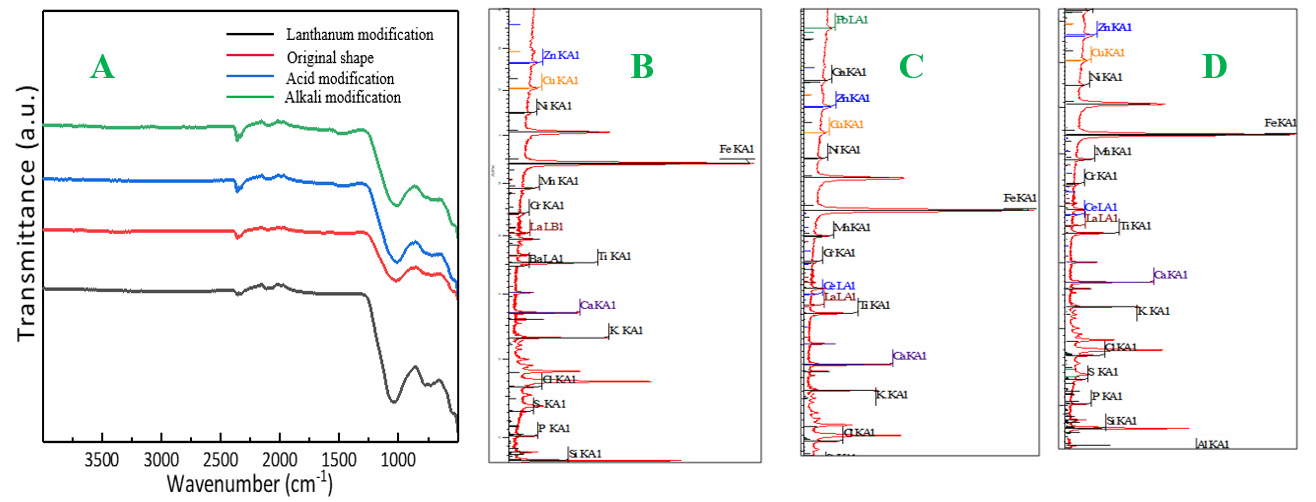
Figure 4. ( A ) Infrared spectra of four modified fly ashes; ( B ) XRF curves of acid modification; ( C ) XRF curves of alkali modification; ( D ) XRF curves of lanthanum modification.